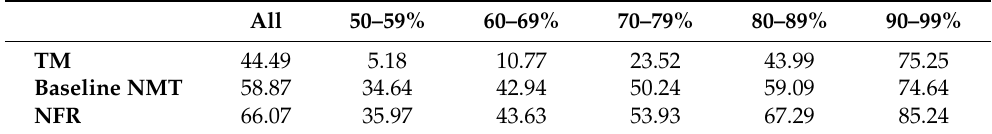
Table 7. BLEU scores for the TM, baseline NMT and NFR system in different FM ranges. All 50–59%